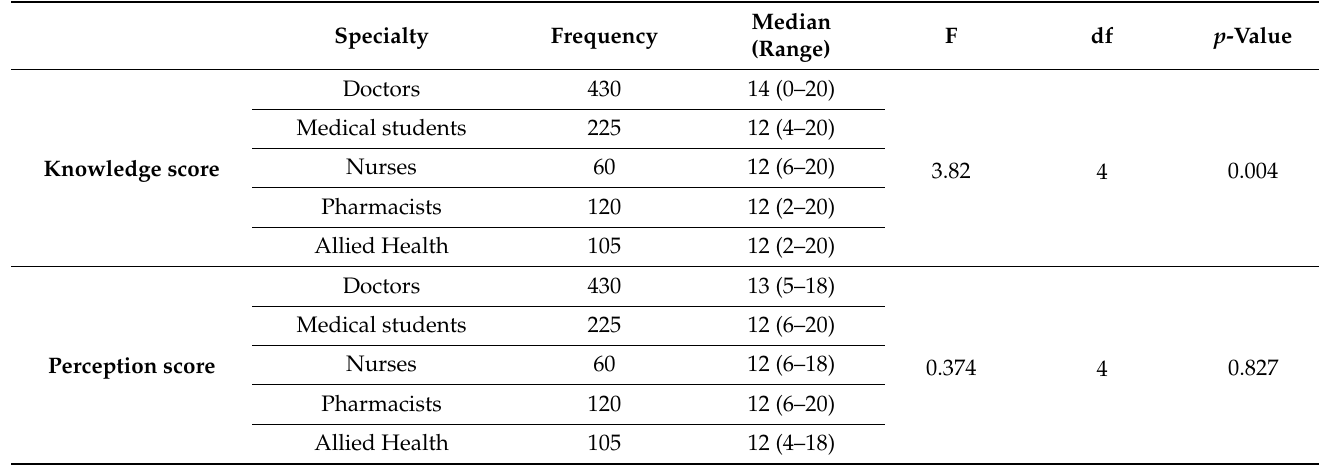
Table 3. ANCOVA test to compare the participants’ knowledge and perception score variations across health specialties.